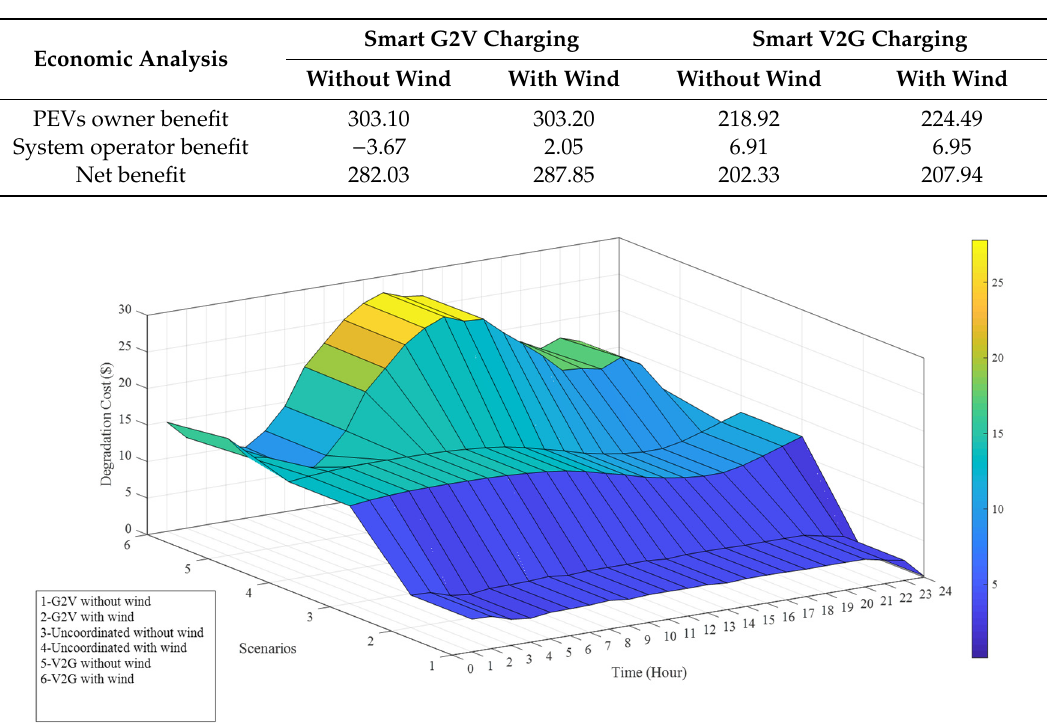
Table 7. The Computational Cost for Different Approaches. Table 6. Various charging mode benefits.